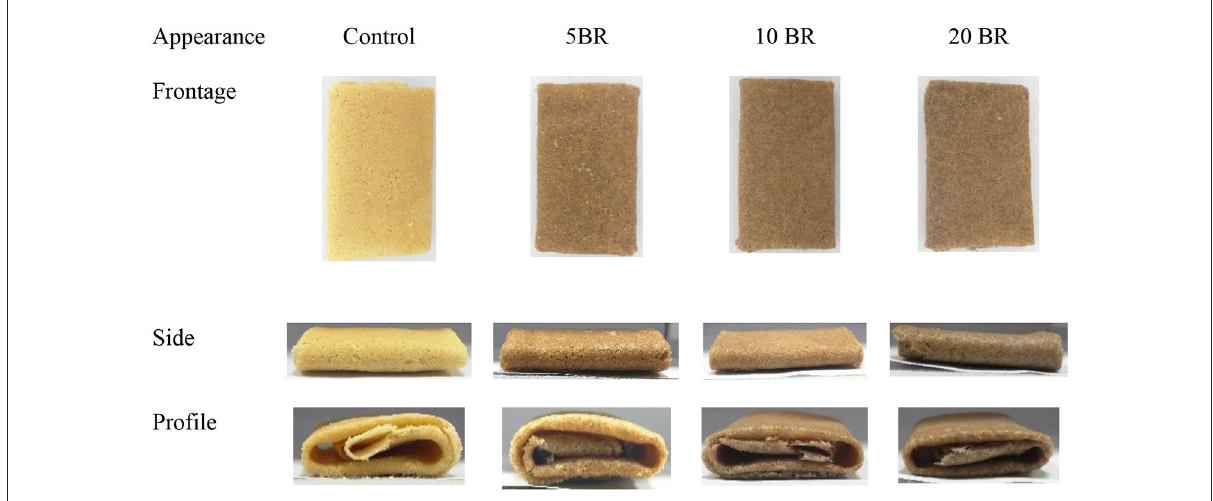
FIGURE1 The appearance of flaky rolls incorporated with black rice flour at different proportions.